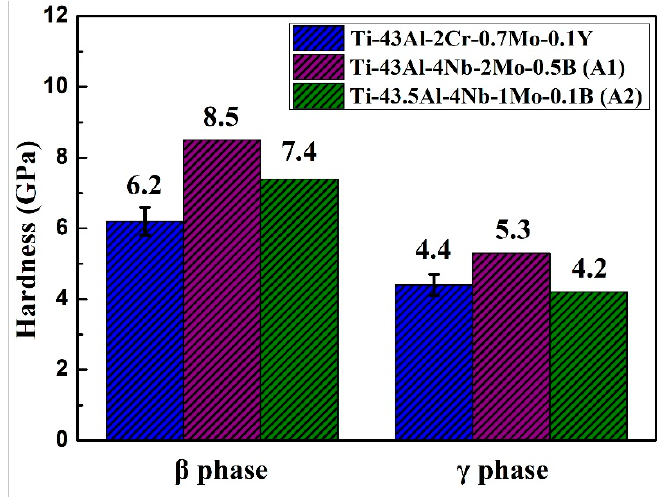
Figure 7. Nanohardness of constituent phases in the Ti–43Al–2Cr–0.7Mo–0.1Y alloy.